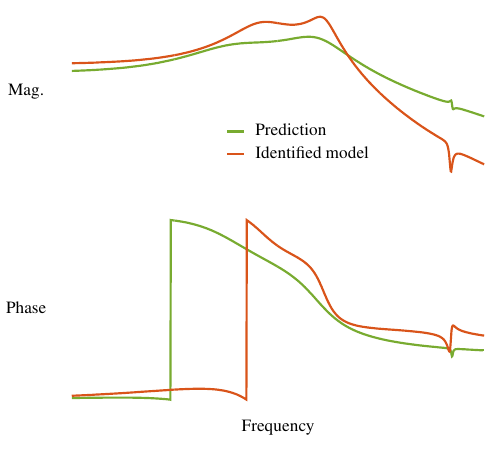
Figure 9. Bode plot of the q gyr / δ wf 4 s frequency response.